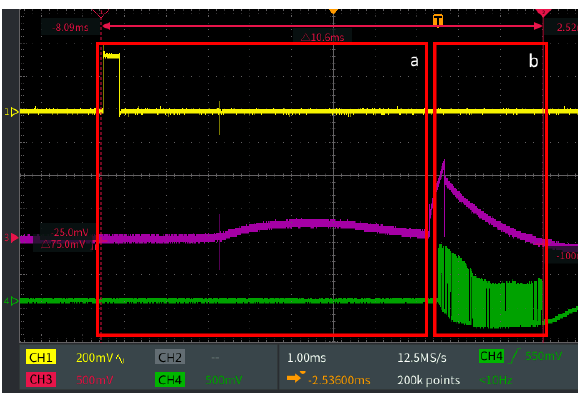
Figure 6. Minimum measured end-to-end latency.